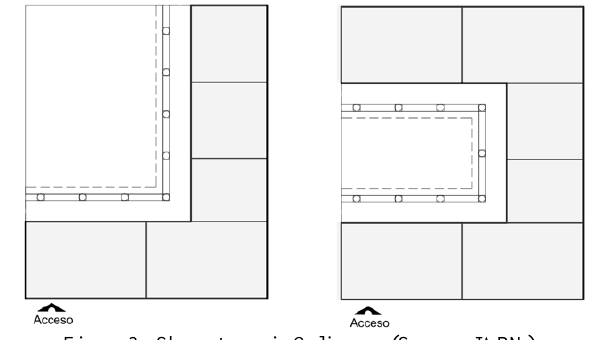
Figure 3. Shape types in Calimaya. (Source: JAPN)